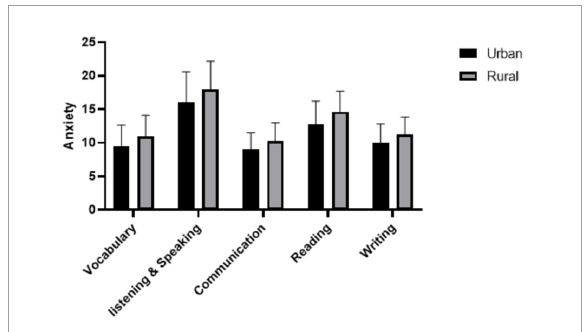
FIGURE2 Comparison of urban and rural students’ foreign language